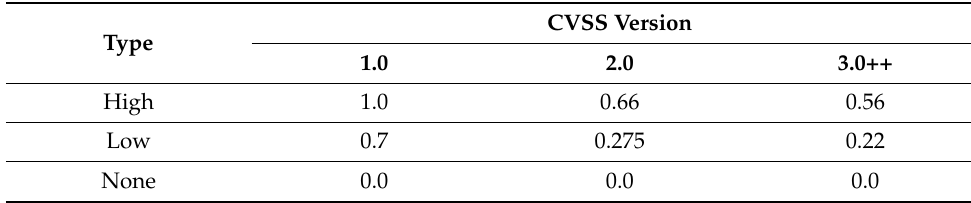
Table 4. CIA impact according to CVSS